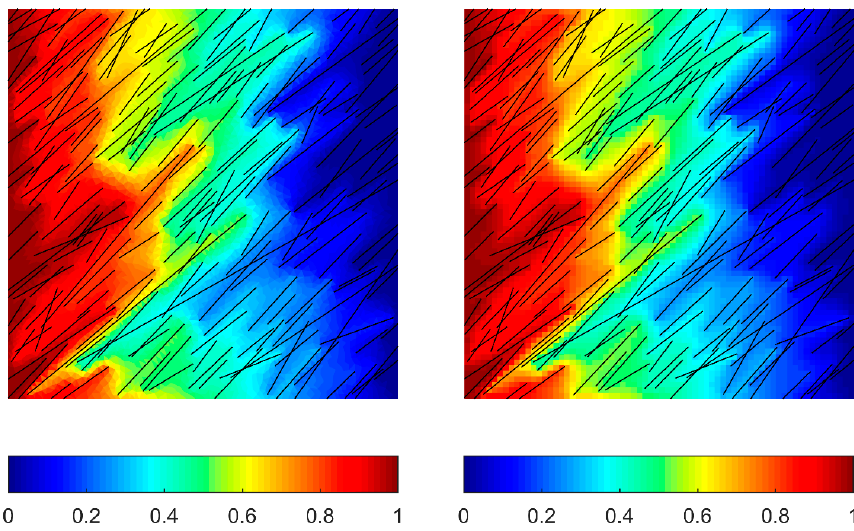
Figure 4. Pressure distribution using DFM-NTPFA ( left ) using 11,448 elements and EDFM-TPFA ( right ) using 4900 elements (i.e., 70 × 70) blocks. ( right ) using 4900 elements (i.e., 70 × 70 )